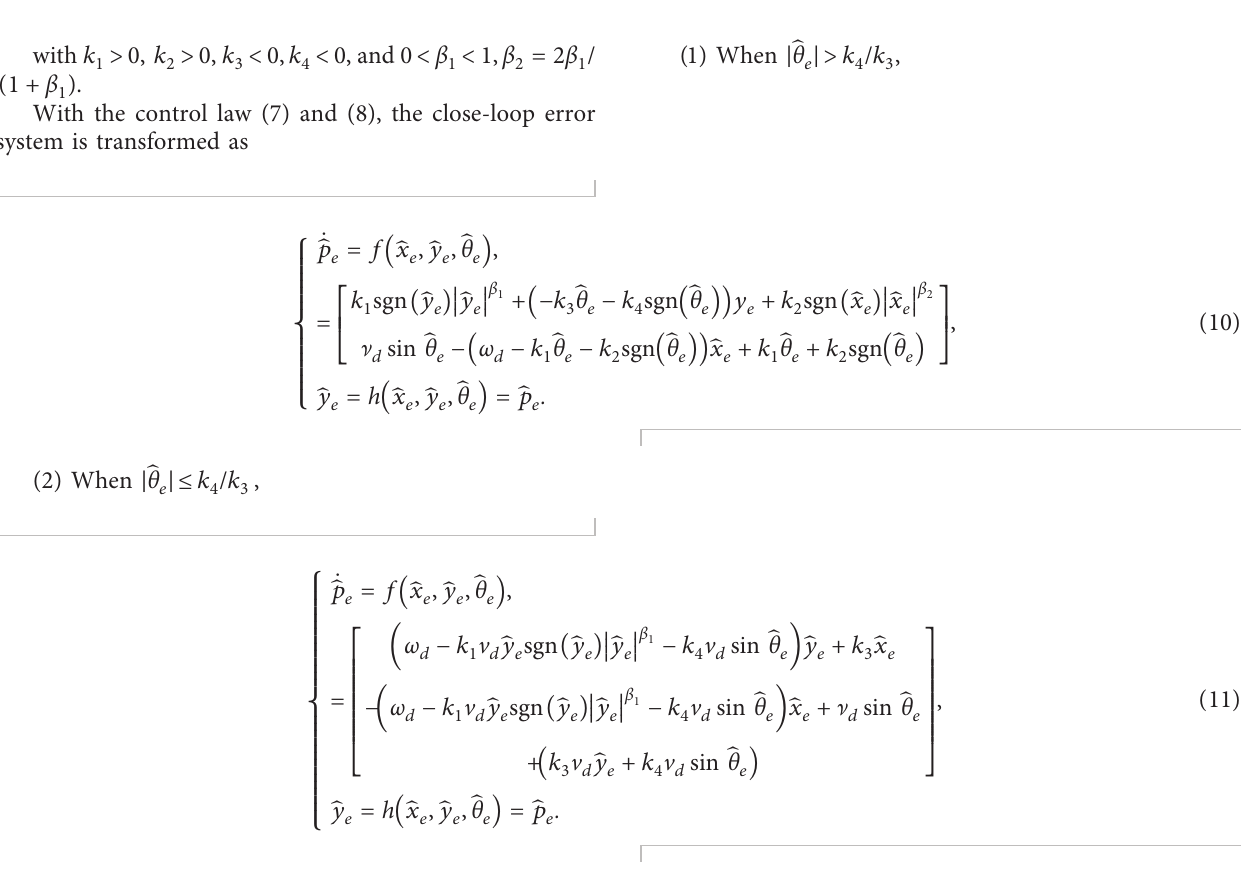
Figure 5: The translated control block for the USV trajectory-tracking.